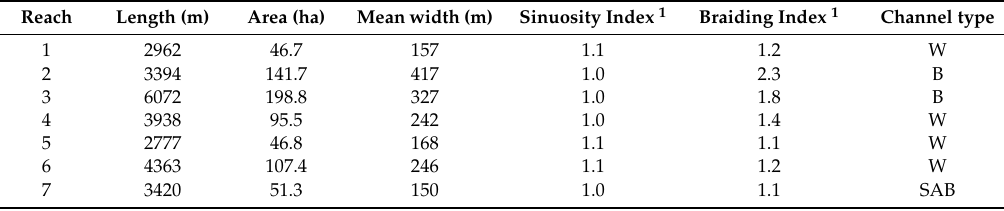
Table 2. Morphological features of identified reaches (referred to the 2019 active channel). W, wandering; B, braided; SAB, sinuous with alternate bars; M, meandering; S,